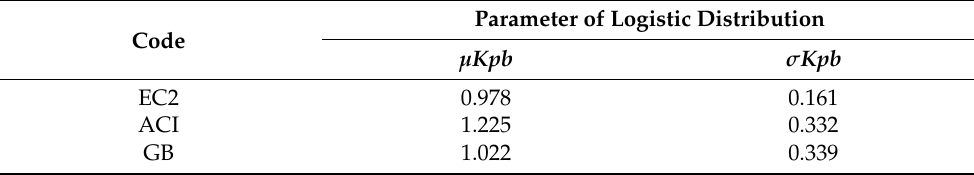
Table 4. Probabilistic properties of the variables considered by the models.